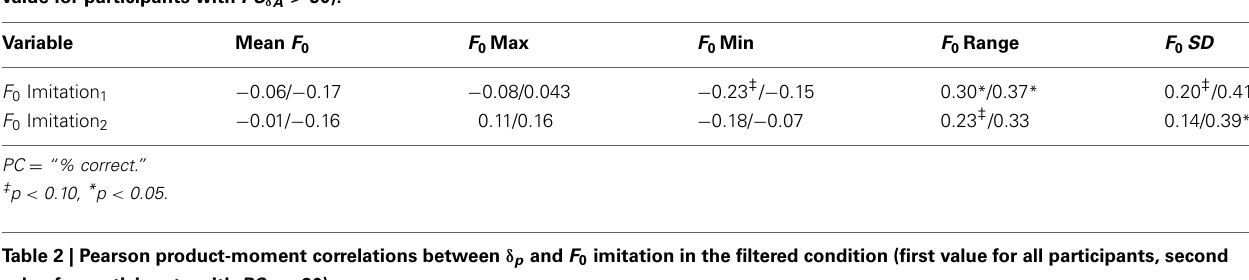
Table 1 | Pearson product-moment correlations between δ p and F 0 imitation in the full signal condition (first value for all participants, second value for participants with PC δ A > 90).